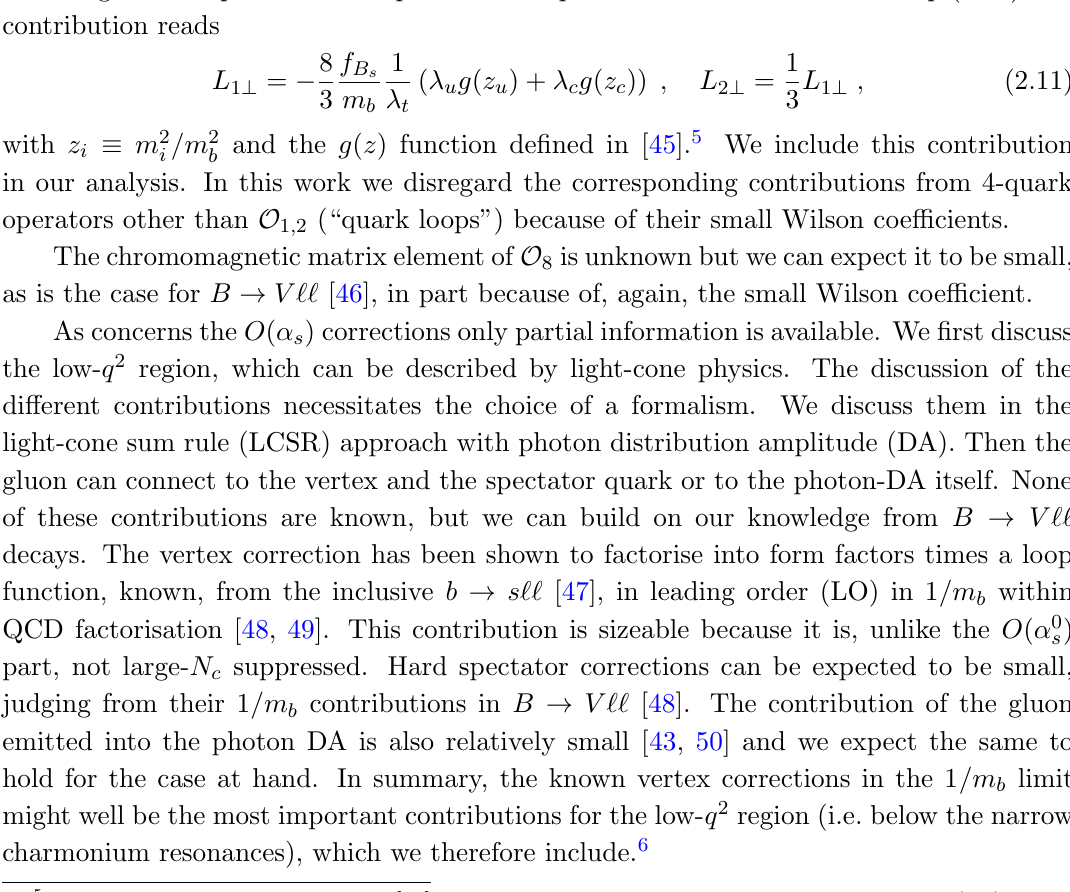
Figure 2 . Long-distance diagrams contributing to the (cid:22) B 0 The empty square or circle denote the insertion of one of the four-quark operators in eq. (2.1) and, respectively, of the operator O 8 . The symbol (cid:10) denotes all the possible ways of attaching an on-shell photon, with exclusion of